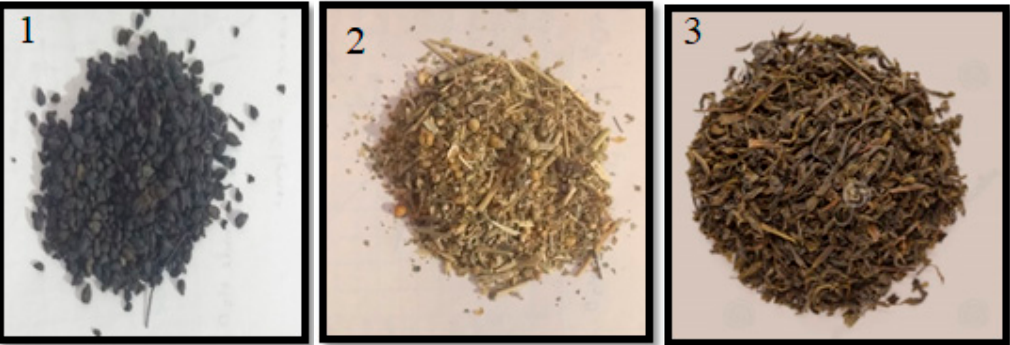
Figure 1. Dry leaves of 1. Vitis vinifera , 2. Withania somnifera , 3. Camelia sinensis . 2.3. Phytochemical Screening of Extracts and Antioxidant Activity Using DPPH Assay 2.3. Phytochemical Screening of Extracts and Antioxidant Activity Using DPPH